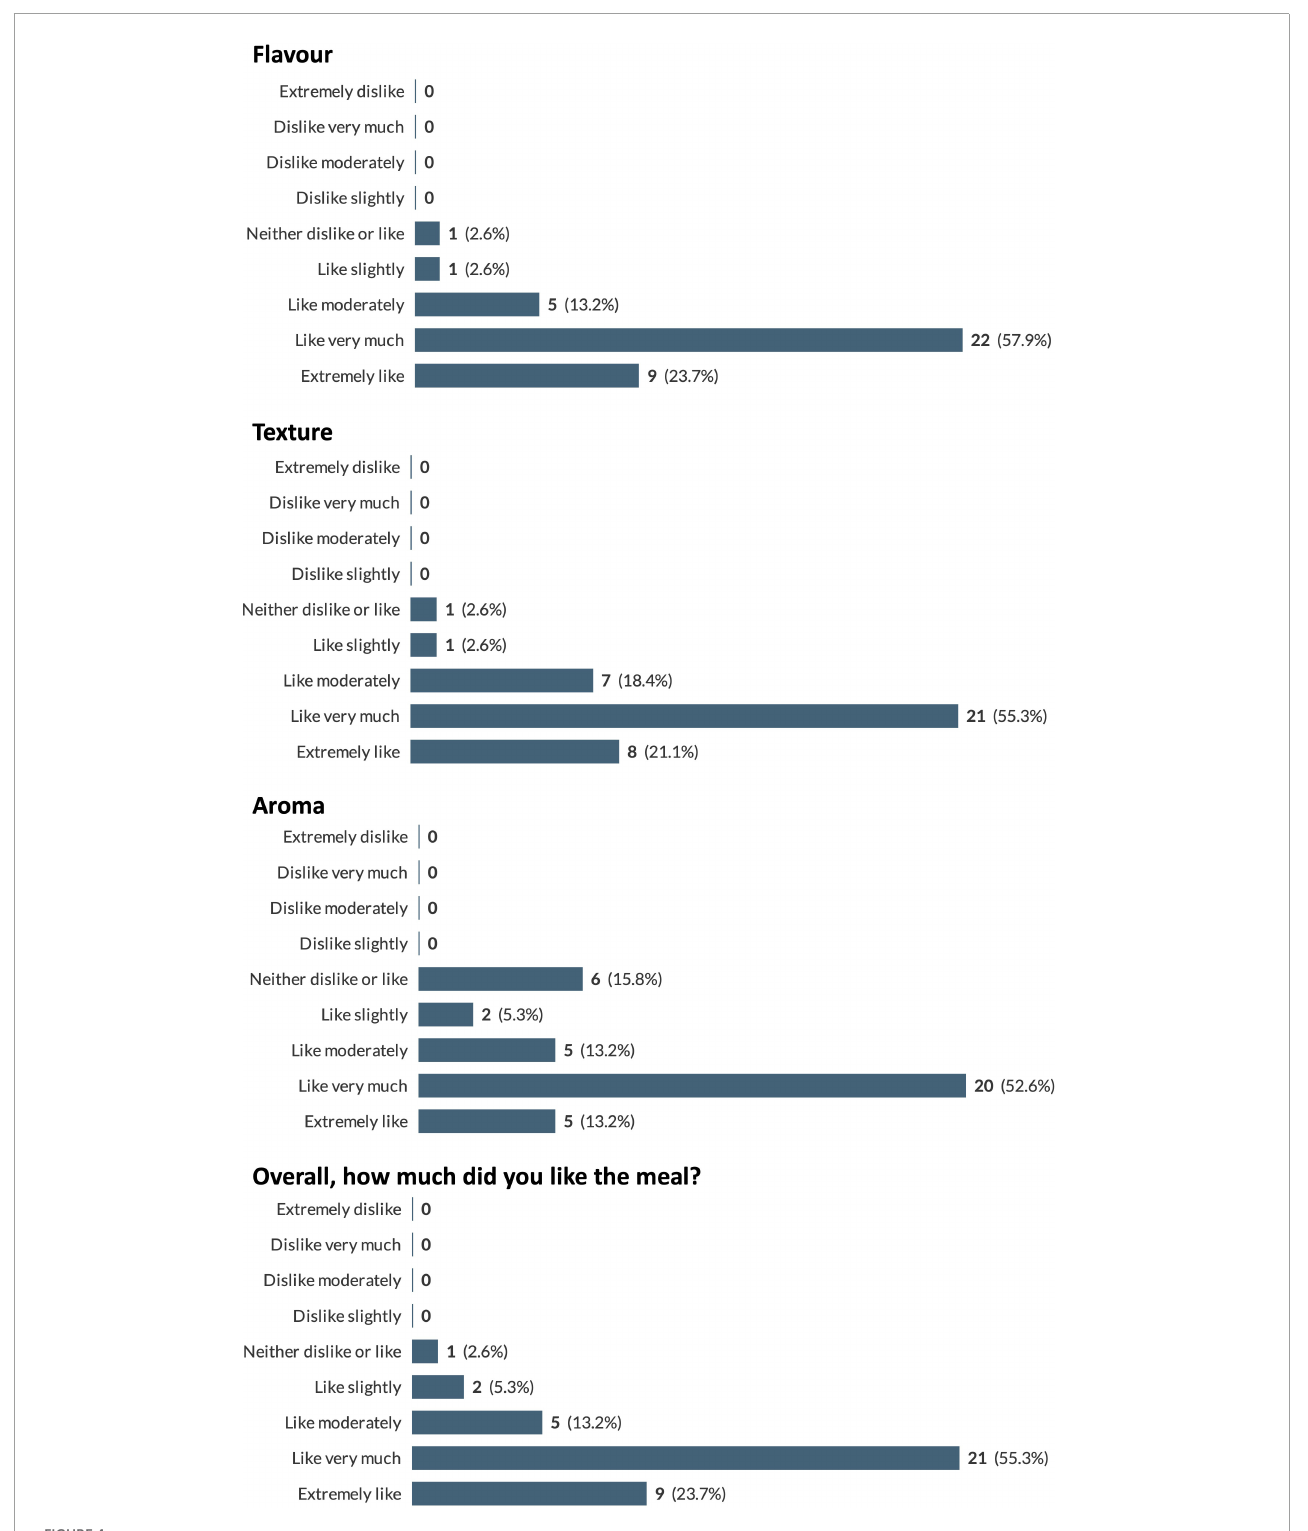
FIGURE4 Pooled participant responses to questions relating to gustatory impressions of the proposed recipes. Displayed as number and (percentage) of responses to each answer option (e.g., 100% would represent that all this question’s responses chose that